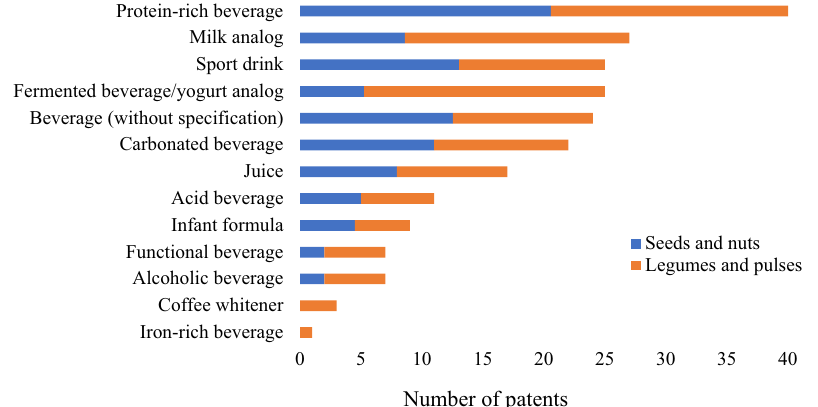
Fig. 5 Number of patents based on beverage types and raw material groups. Patents that have opted for seeds and nuts are represented in blue, whereas the number of patents that have used legumes and pulses is represented in orange. *The same patent can mention more than one beverage type as